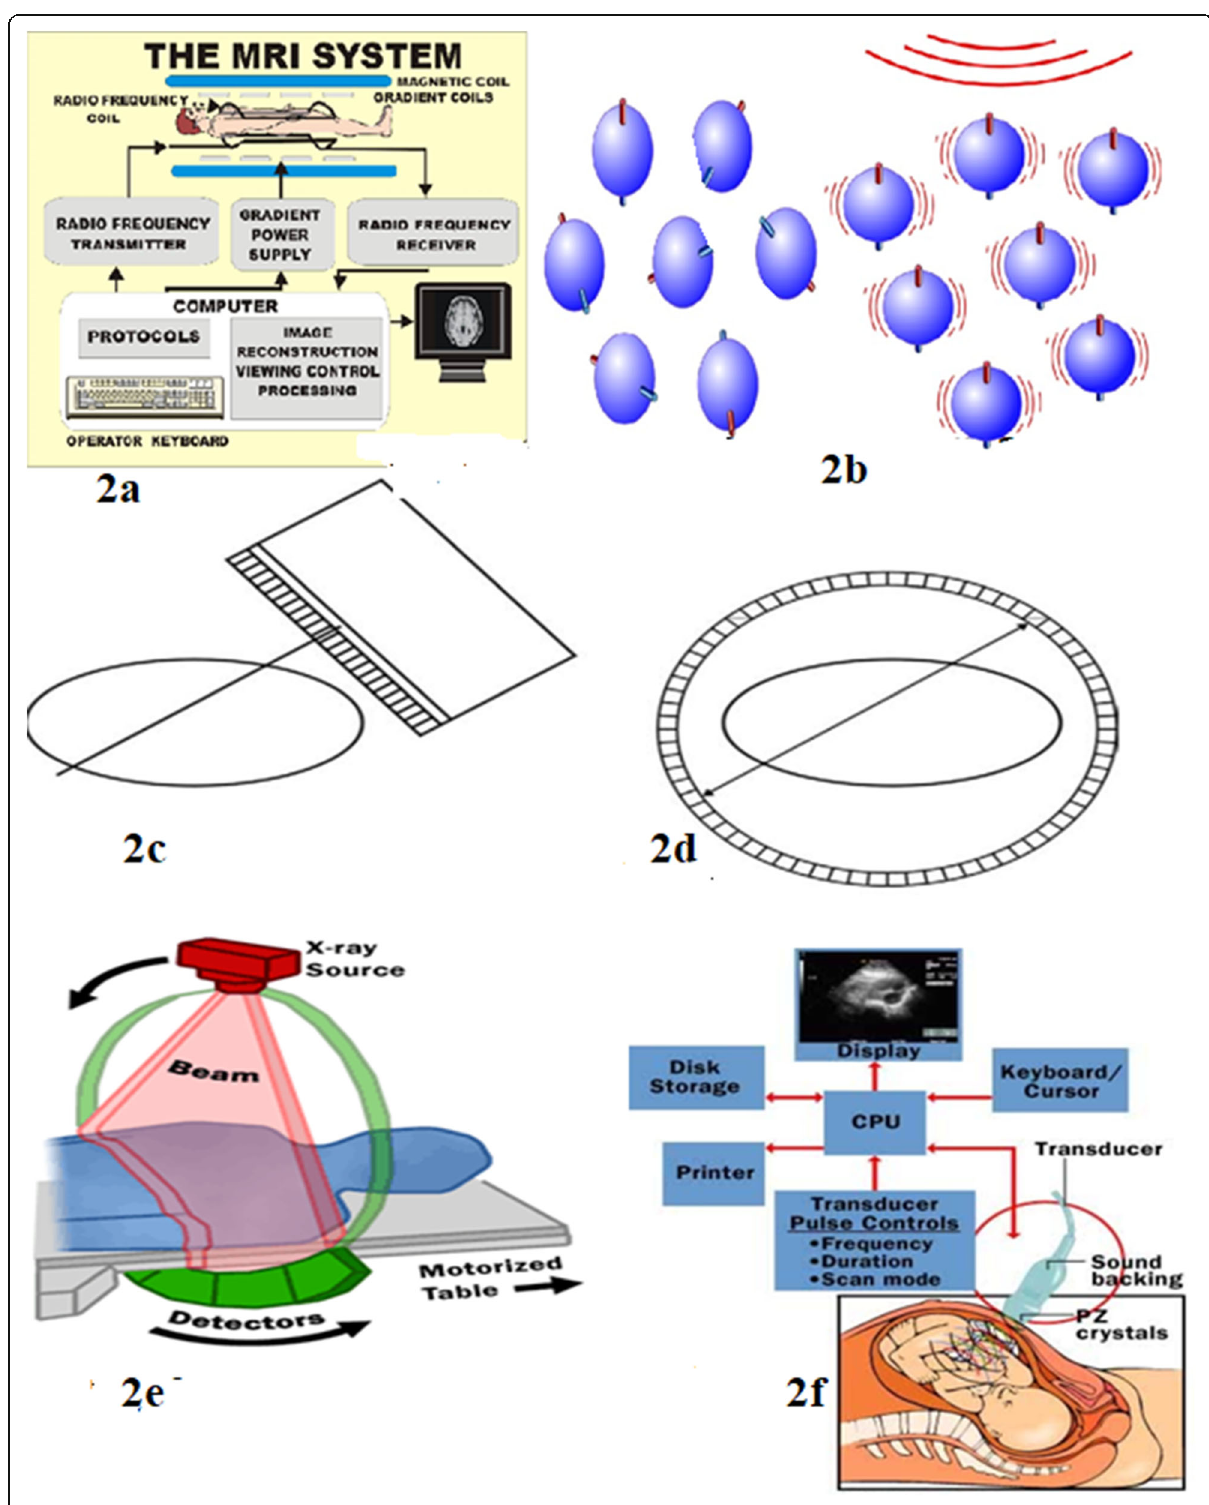
Fig. 2 a MRI imaging system. b Alignment of protons without magnetic field. c Alignment of protons with magnetic field [7, 8]. d Shows the image acquisition of the SPECT system, where the gamma camera rotates about the patient to acquire a projection image at each angle. e With the PET imaging system, the patient is located within a ring of detectors and the positron annihilation emits two gamma photons in opposite direction which are picked up by two detectors [9]. f CT imaging system [10]. g Ultrasound imaging system